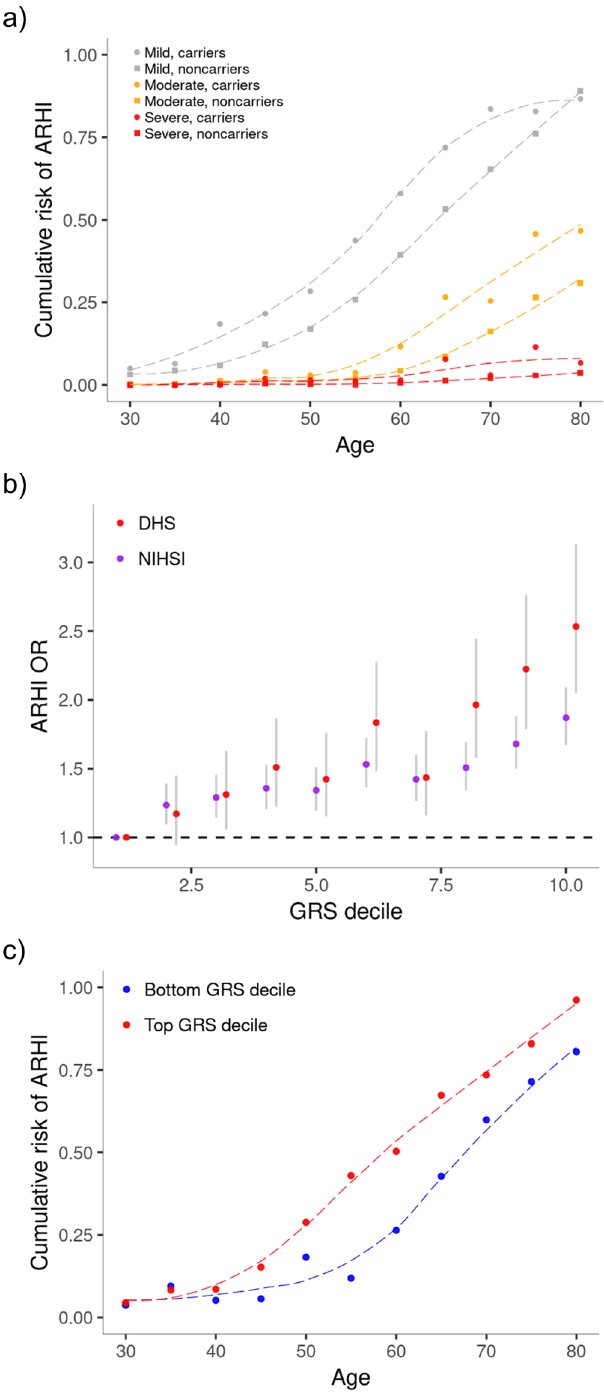
Fig. 2 ARHI risk for rare variants and a common variant GRS. a The fraction of individuals with mild (gray), moderate (orange), and severe (red) hearing impairment in the DHS dataset ( N = 11,484) among the 4.9% of subjects that are carriers of any of the 16 rare ARHI variants (dots) and the 95.1% that are not carriers (squares), shown for different age groups. The corresponding dashed lines are polynomial regression lines of best fi t. b The risk of ARHI for each GRS decile compared to the bottom decile expressed in ORs. The ORs from the DHS dataset (4140 cases and 7344 controls) are represented with red dots and the ORs from the NIHSI dataset (9619 cases and 298,609 controls) are represented with purple dots. The gray lines represent 95% con fi dence intervals. The dashed line is the reference for the bottom GRS decile (OR = 1). c The fraction of individuals with ARHI among subjects in the DHS dataset ( N = 11,484) in the bottom GRS decile in blue and the top GRS decile in red, shown for different age groups. The corresponding dashed lines are regression lines of best fi